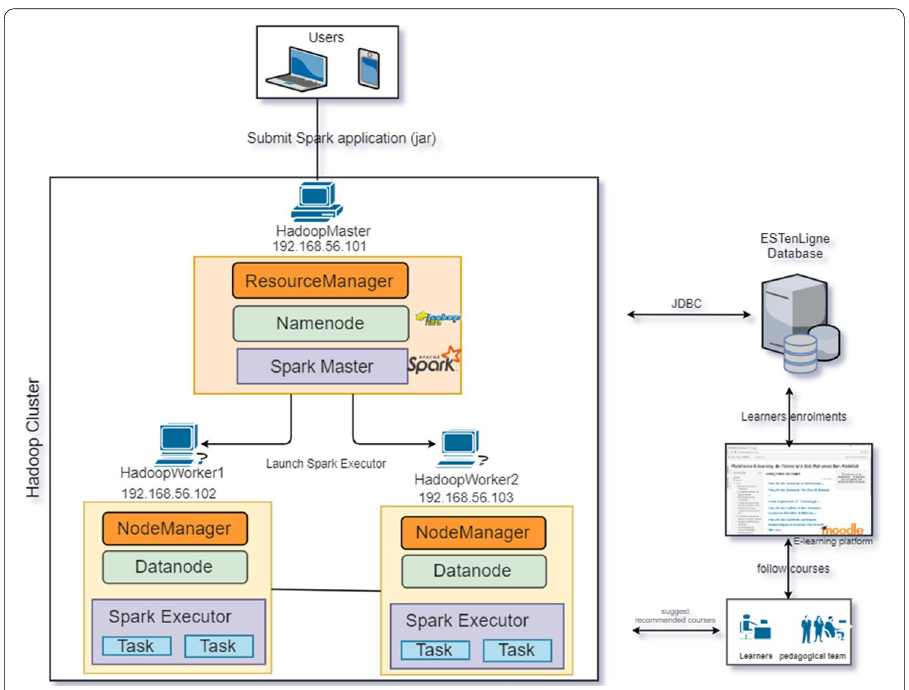
Fig. 6 Hadoop cluster architecture: It is a distributed computing environment based on Hadoop cluster of three